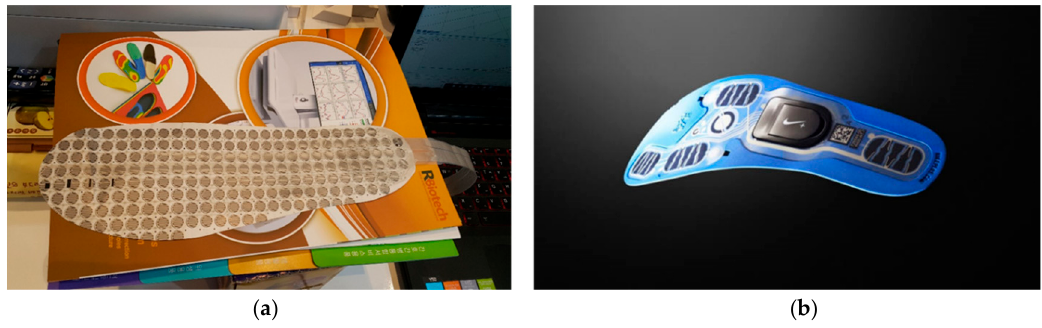
Figure 1. ( a ) FlexinFit pressure sensor, ( b ) Samsung’s smart insole.